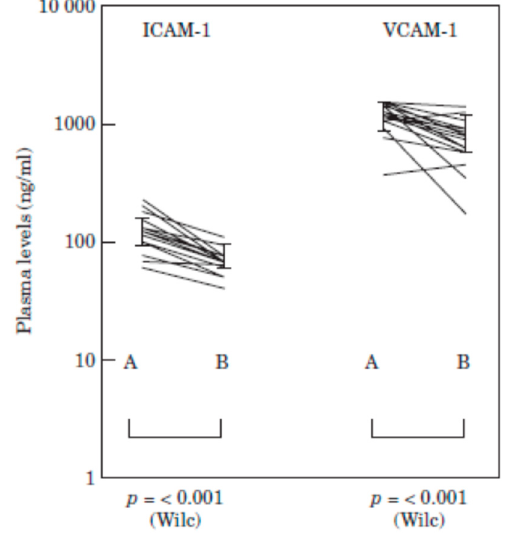
Figure 3. Changes in plasma levels if ICAM-1 and VCAM-1 in patients with CVD before (A) and after (B) 60 days of treatment with MPFF. A logarithmic scale has been used because of the differences in the absolute levels of the two molecules. p -levels are Wilcoxon ranked-sum test. The thick lines join the respective median levels. Vertical lines represent interquartile range. (Reproduced from [81] with permission from the publisher).